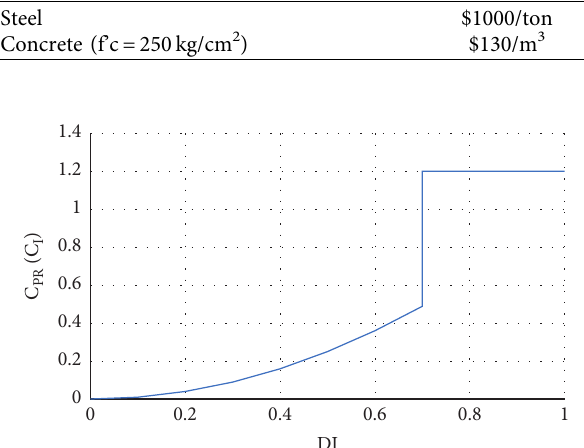
Figure 2: Repair cost as function of damage index.